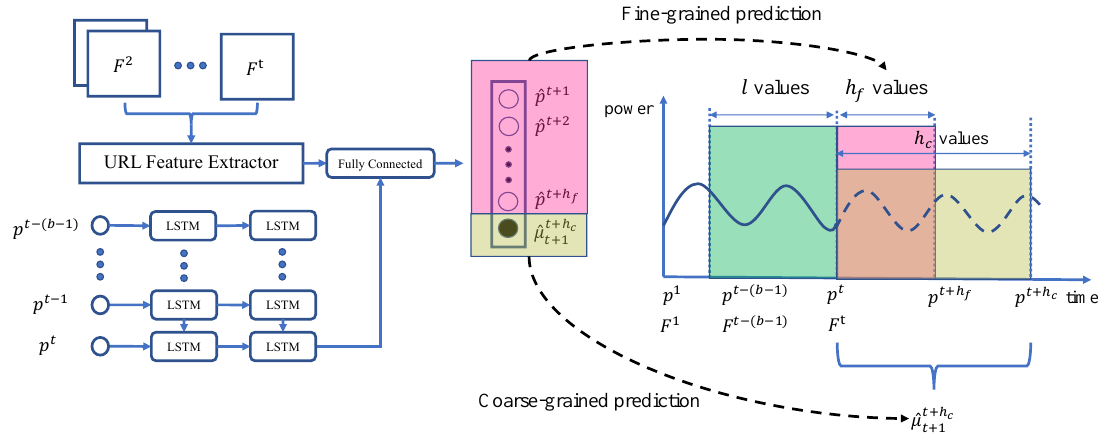
Figure 4. The framework of power consumption